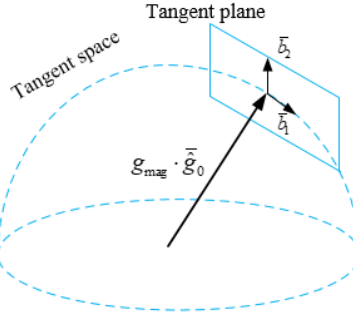
Figure 3. The tangent space model of gravity. The gravity magnitude is the radius of a